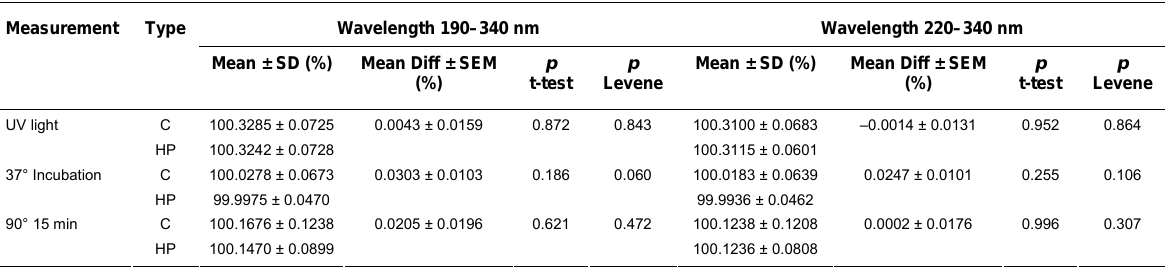
Homeopathic Preparations and Controls that were 8 Exposed to External Factors*